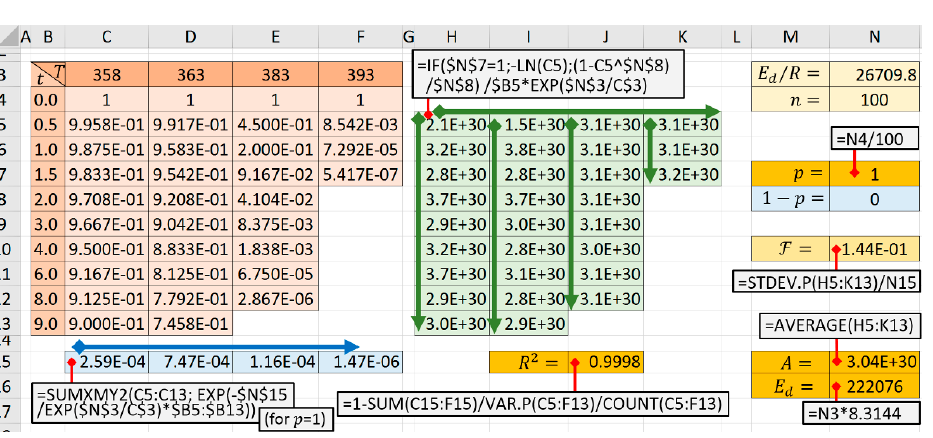
Figure 1. Excel worksheet for identification of the kinetic triplet (model parameters). 1. The initial data represent the dependence of the relative number of living cells or spores F ij over time (min) at different temperatures (358, 363, 383, and 393 K), entered into the cell range C3:F13 (Figure 1). 2. Sufficiently arbitrary initial values of the parameters E d / R and n were entered into cells N3 and N4 where, after the Solver execution, optimal values were formed. The dialog box Subject to the Constraints was defined as an integer. In this example, the values were set to 11,111 and 11, respectively. The Excel formulas in cells N16 and N7 determined the optimal values E d and p